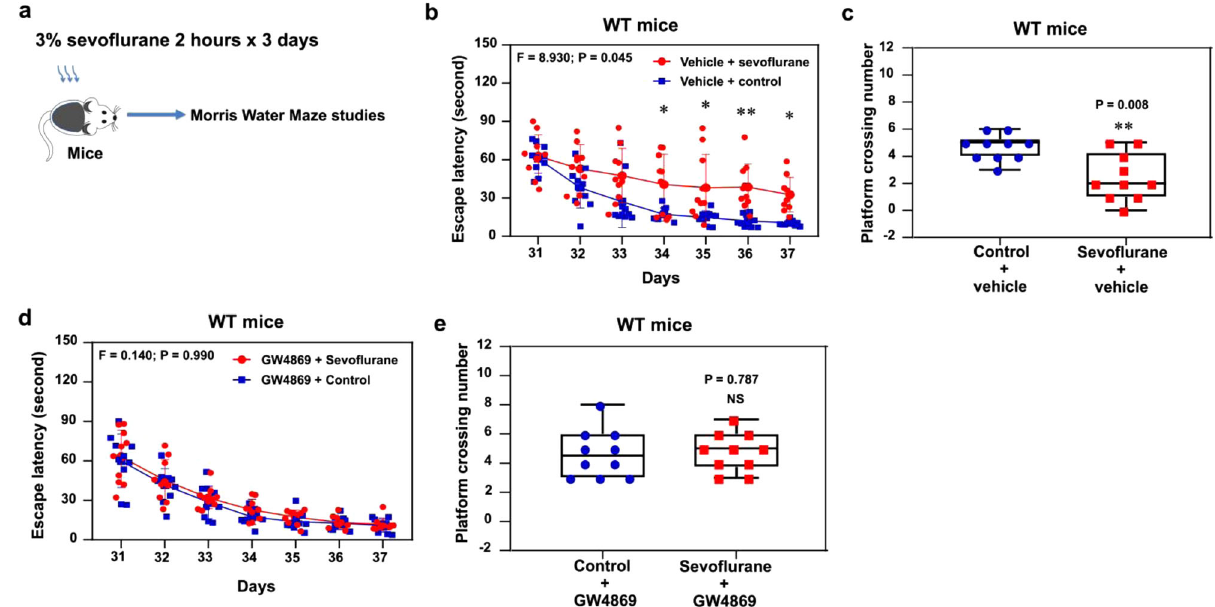
Fig. 4 GW4869 mitigated the sevo fl urane-induced cognitive impairment in mice. a Experimental design. Effects of sevo fl urane on cognitive function in mice pre-treated with vehicle ( b , c ) in MWM. Effects of sevo fl urane on cognitive function in the mice pre-treated with GW4869 ( d , e ) in MWM. N = 10 mice in each group. Two-way ANOVA with repeated measurement and post-hoc analysis with Bonferroni were used to analyze the data presented in Fig. 4b, d. The P values of the two-way ANOVA refer to the interaction of group (control condition versus sevo fl urane) and days (day 31 to 37). The P values of post-hoc analysis with Bonferroni refer to the differences in escape latency between sevo fl urane and control condition on each day. The Mann – Whitney U test was used to analyze the data presented in Fig. 4c, e, the P values refer to the difference of the number of platform crossing between control condition and sevo fl urane. * P < 0.05 and ** P < 0.01. The box indicates median (50 th percentile), the fi rst quartile (25 th percentile), and the third quartile (75 th percentile) of the number of platform crossing; the upper and lower bar indicates the minimum and maximum of platform crossing number. Error bar indicates standard deviation. MWM Morris water